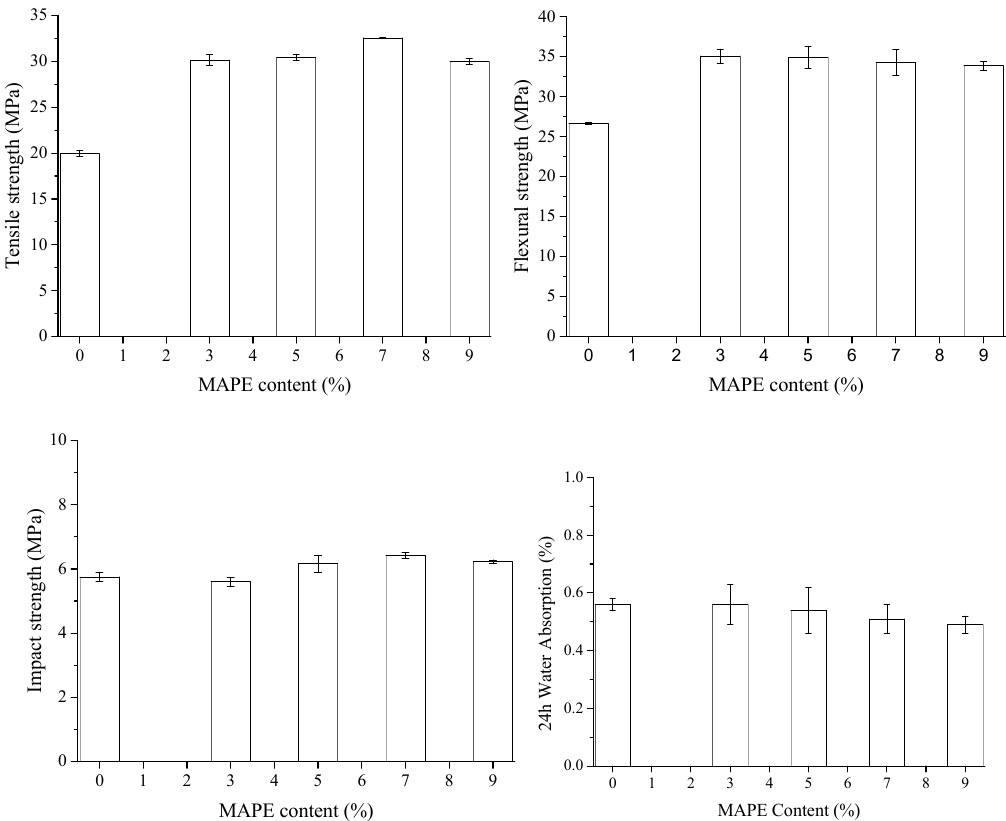
Figure 7. Impacts of maleic anhydride-grafted polyethylene (MAPE) content on mechanical properties and water resistance of ONP–HDPE composites.